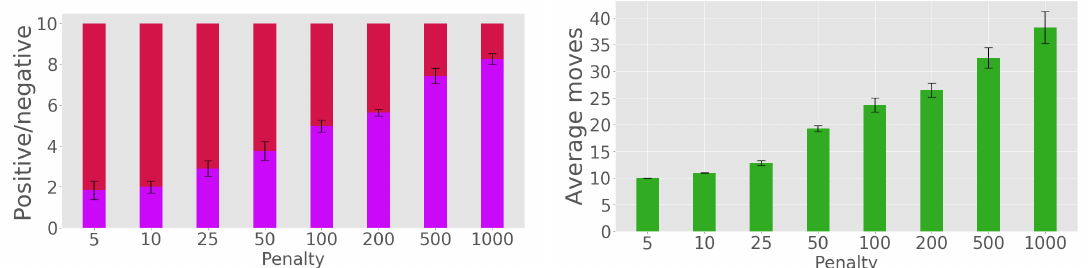
Figure 11. Two-position observations: Positive–negative counts ( left ) and number of steps needed for sorting ( right